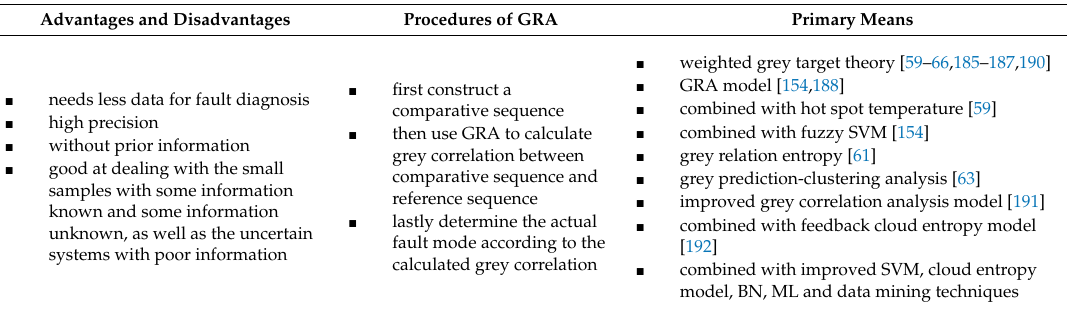
Table 9. A summary for the application of GST in DGA-based transformer fault